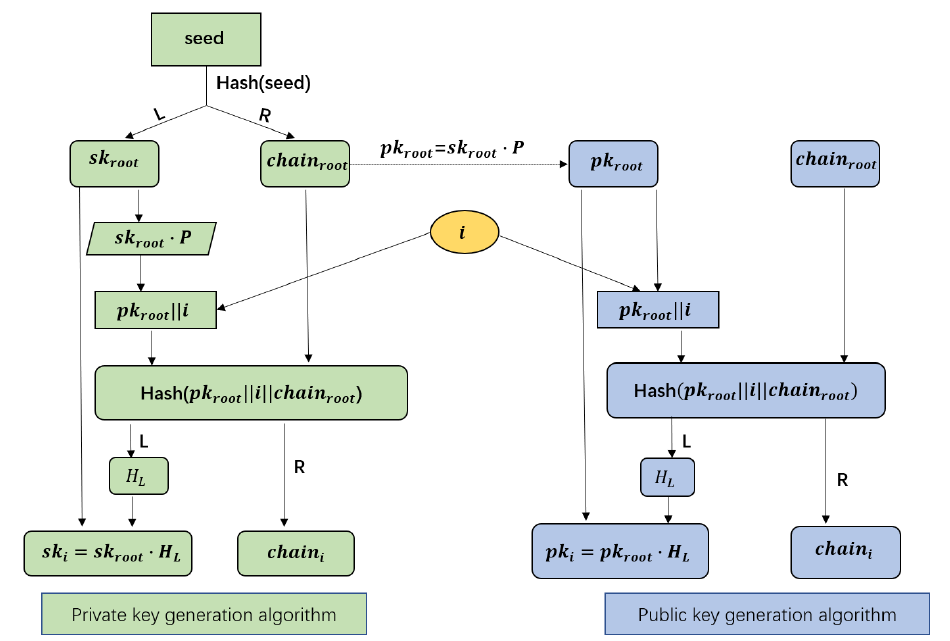
Figure 2. Key generation